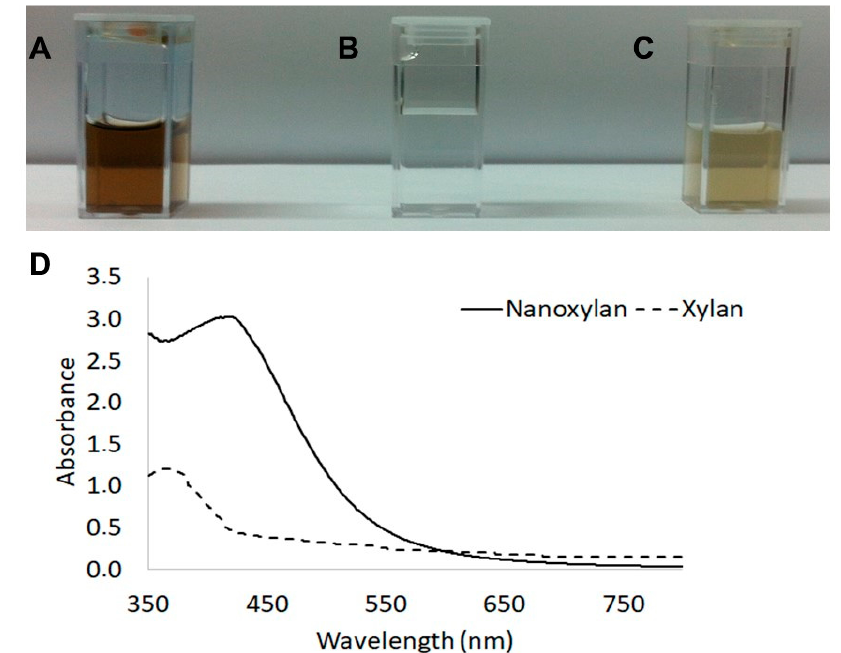
Figure 2. Nanoxylan suspension ( A ), silver nitrate 1 mM solution ( B ), and xylan solution (10 mg/mL) ( C ). The darker color in the nanoxylan suspension is related to the reduction in the silver particles. UV–vis absorption spectrum of the nanoxylan suspension and xylan solution ( D ).